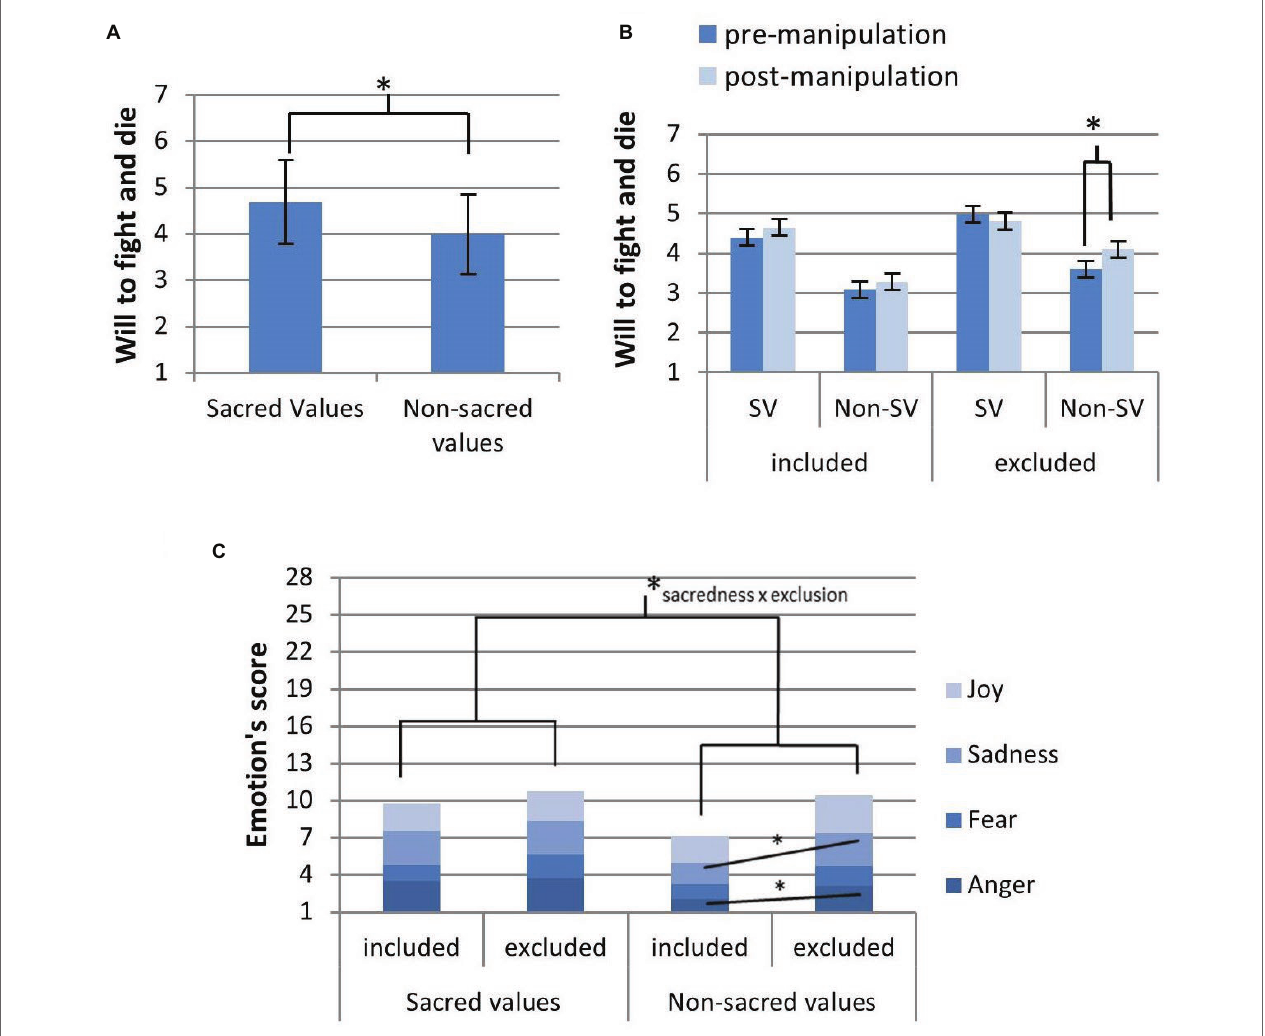
FIGURE 2 | Behavioral analysis results including: (A) higher premanipulation will to fight and die for sacred versus nonsacred values ( t (37) = 10.831, p < 0.001, and Cohen’s d = 0.80), (B) an increase in will to fight and die for nonsacred versus sacred values in excluded participants compared to nonexcluded participants after the experimental manipulation (Wilks’ λ = 0.852, F (1,35) = 6.077, p = 0.019, and η 2 p = 0.148), and (C) higher emotional intensity ratings (out of 28 possible points) at the thought of defending sacred versus nonsacred values ( t (36) = 2.59, p = 0.014, and Cohen’s d = 0.40) and higher emotional intensity ratings for nonsacred values versus sacred values in the social exclusion versus inclusion condition (Wilks’ λ = 0.848, F (1,35) = 6.26, p = 0.017, η 2 p = 0.152), driven by sadness (Wilks’ λ = 0.834, F (1,35) = 6.99, p = 0.012, and η 2 p = 0.166) and anger (Wilks’ λ = 0.888, F (1,35) = 4.43, p = 0.043, and η 2 p =